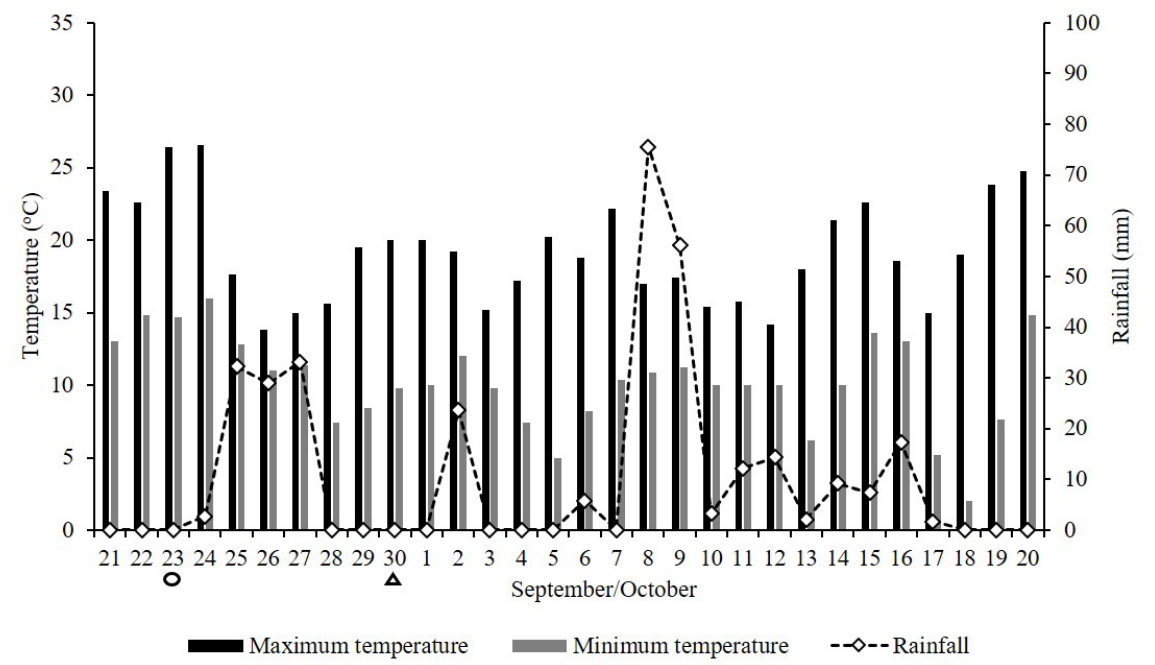
Figure 1. Climatic conditions before and following treatments applications in September and October 2015/2016 growing season in São Joaquim, SC. Application dates are indicated by a circle (full bloom) and a triangle (7 days after full bloom – DAFB) bellow the “x” axis. Source: INMET/ BDMEP (São Joaquim,